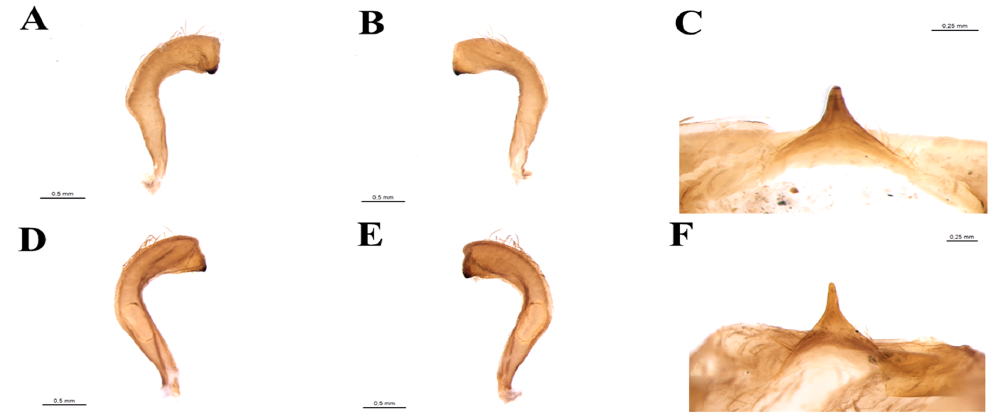
Figure 7. Paramere of T. rosai sp. nov.: ( A ) dorsal view, ( B ) ventral view; ( C ) median process of the pygophore; Paramere of T. sordida : ( D ) dorsal view, ( E ) ventral view; ( F ) median process of the pygophore.